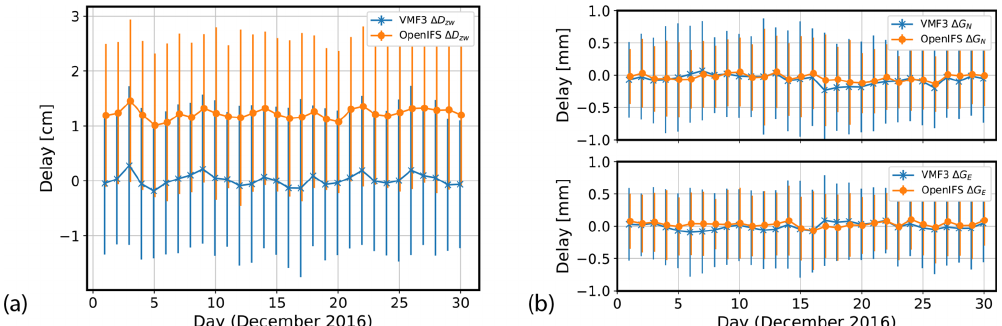
Figure 2. The mean and standard deviation of the fitted parameters: (a) zenith wet delay ( (cid:49)D zw ) and (b) north and east gradient delays ( (cid:49)G N on top and (cid:49)G E at the bottom) for the a priori models for December 2016. Notation is as in Fig.